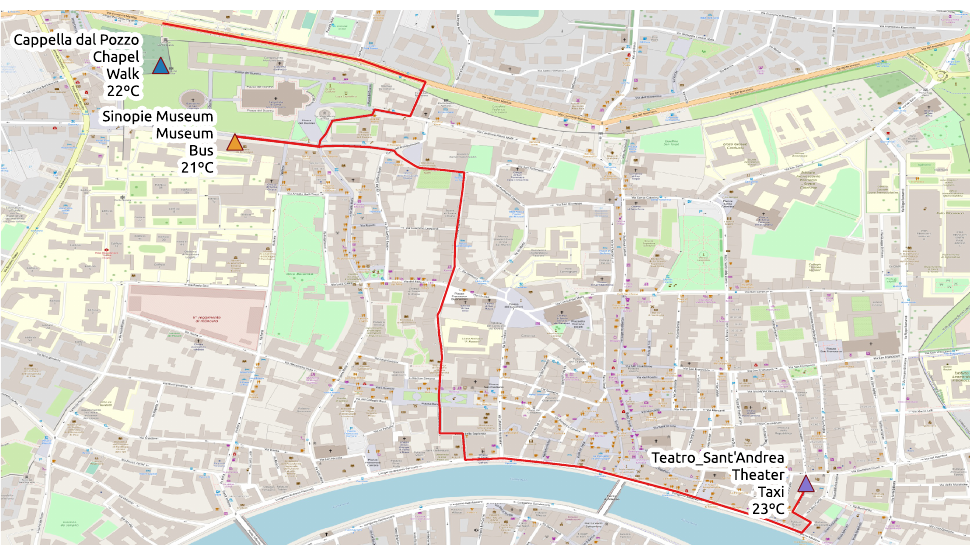
Figure 1. Example of tourist trajectory in the city of